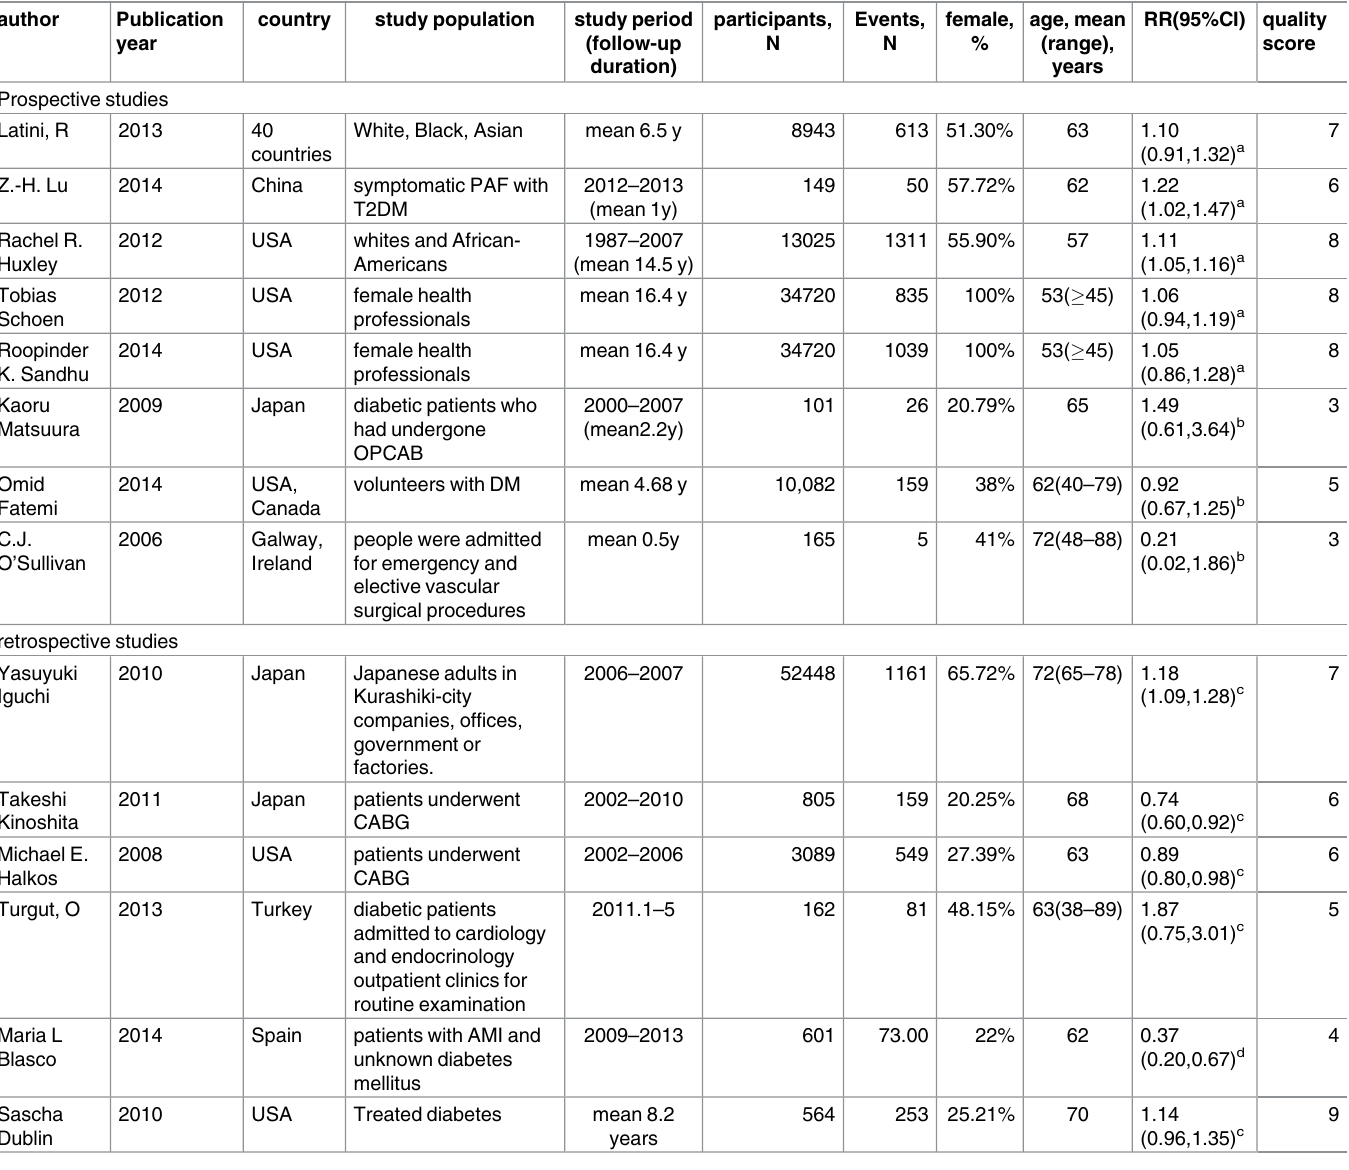
Table 1. Characteristics of prospective and retrospective studies on HbA1c levels and risk of atrial fibrillation.